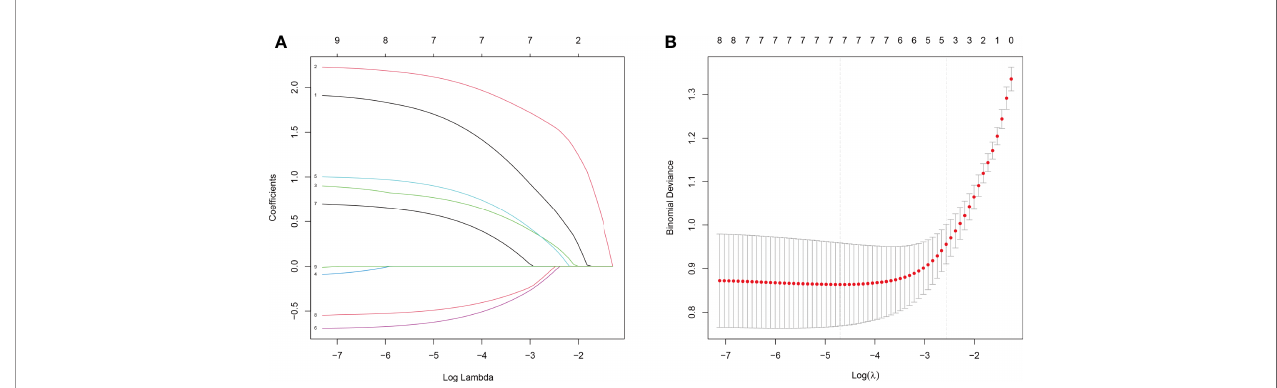
FIGURE 2 | Results of the LASSO regression analysis. (A) Plot of the LASSO coef fi cient pro fi les. (B) Tuning parameter ( l ) selection cross-validation error curve.